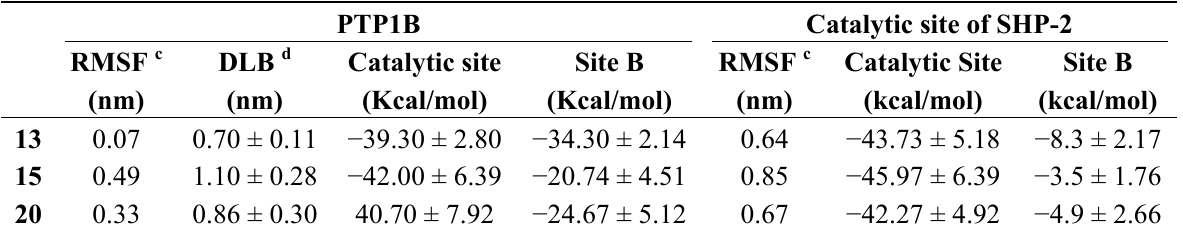
RMSF c : the root mean square fluctuations for heavy atoms of small molecule during the simulations; DLB d : average Distances between Ligands and central point of site B in protein PTP1B during the